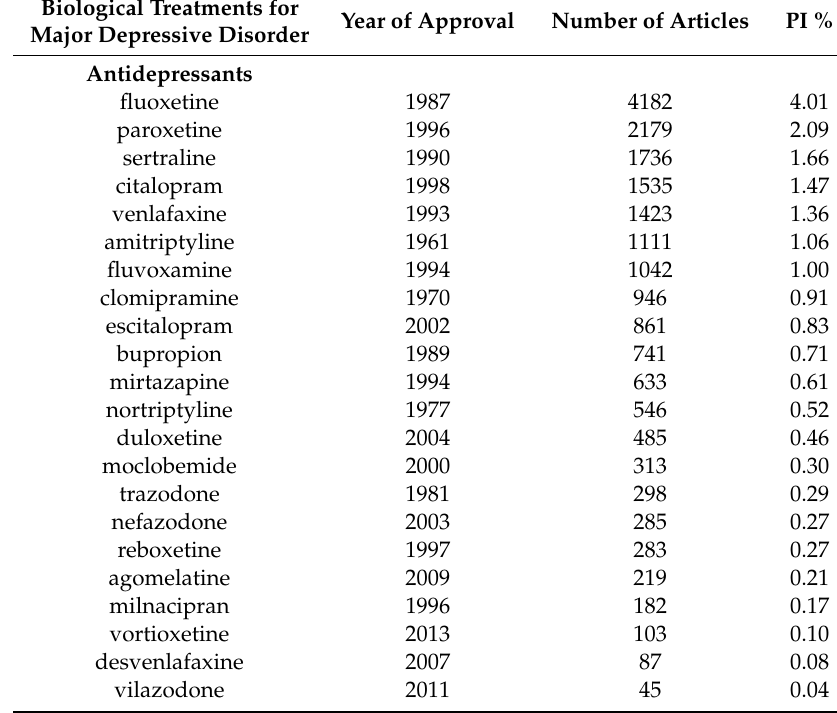
Table 3. The PI of 23 antidepressants and neurostimulation therapies in Psychiatry ( n = 104,335). Biological Treatments